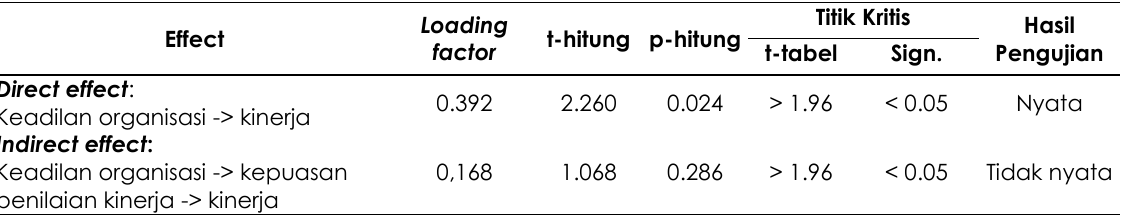
Tabel 10. Hasil pengolahan prosedur bootstrapping pengujian